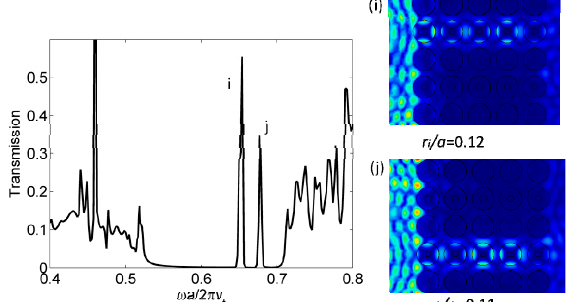
Figure 4. The multichannel wavelength multiplexer: ( Left panel ): Transmission spectrum of the antisymmetric Lamb wave when the inner radius inside waveguides i and j are r i /a = 0.12 and r j /a = 0.11; ( Right panel ): Displacement field distributions at the frequency of the two narrow pass bands i and j . The geometric parameters of the multiplexer are h/a = 0.45, r/a = 0.4, l/a = 0.2.